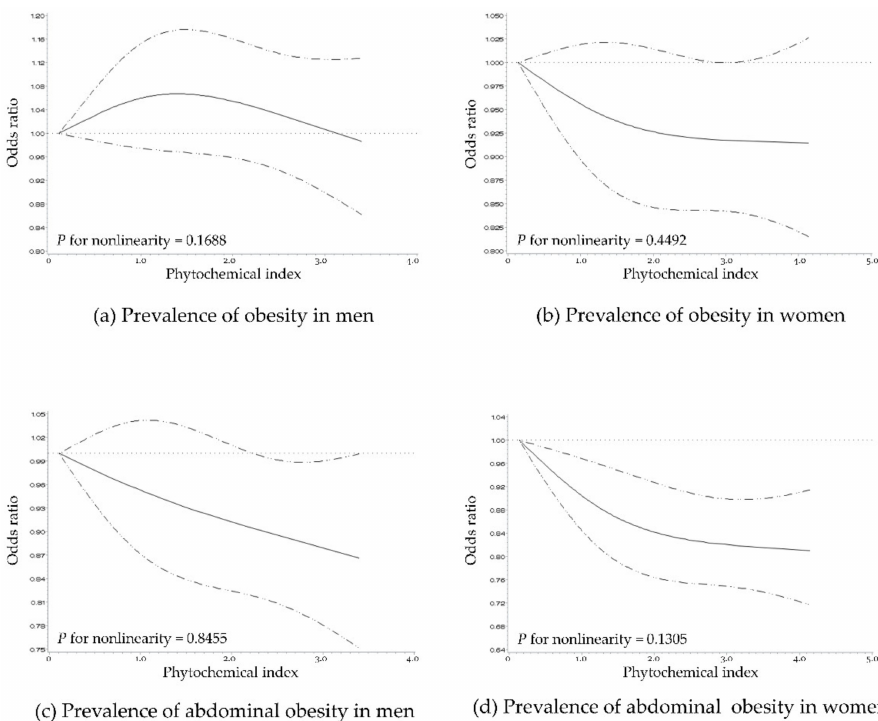
Figure 1. Multivariable adjusted odds ratios (95% confidence intervals) for the nonlinear relationship between phytochemical index and prevalence of obesity and abdominal obesity in Korean men and women. The prevalences of obesity in men (a) and women (b) and the prevalence of abdominal obesity in men (c) and women (d) were evaluated using restricted cubic splines. The model was adjusted for age (19–29, 30–39, 40–49, 50–59, and ≥ 60 years), education level (lower than high school education and high school educated or higher), household income (mid-low or lower and mid-high or higher), smoking status (active smokers and non-smokers), alcohol consumption (drinkers and non-drinkers), physical activity (low, mid, and high), total energy intake (continuous), and level of intake of meat and meat products (continuous), sweets (continuous), and dairy products (continuous). Obesity was defined as having a body mass index ≥ 25 kg / m 2 according to the World Health Organization criteria for Asian populations. Abdominal obesity was defined as having a waist circumference ≥ 90 cm and ≥ 85 cm for men and women, respectively, according to the Korean Society for the Study of Obesity